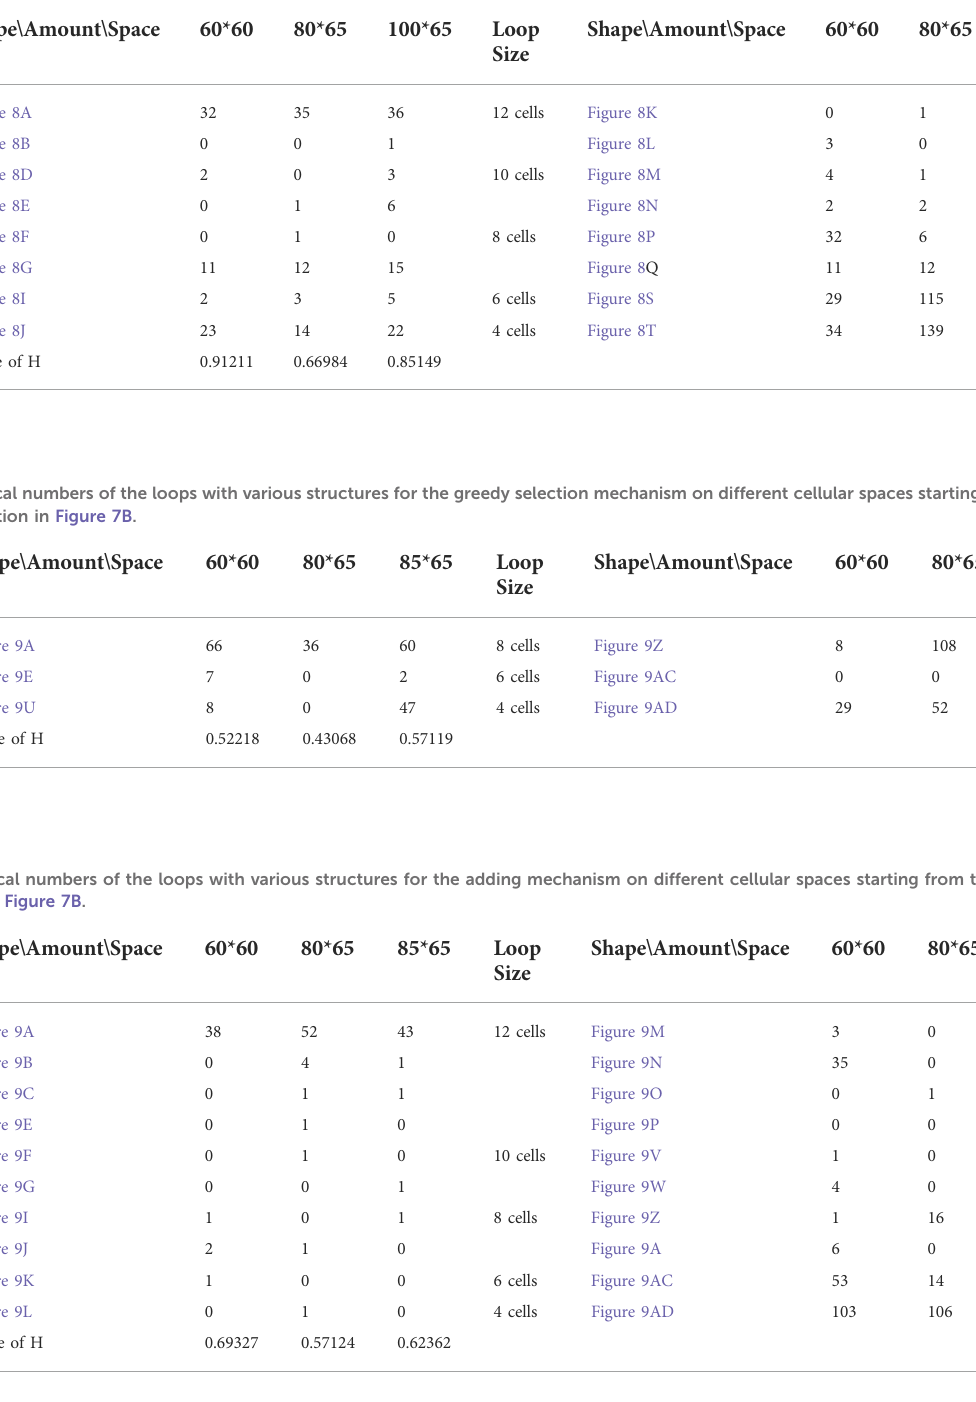
TABLE 4 Statistical numbers of the loops with various structures for the changing mechanism on different cellular spaces starting from the initial con fi guration in Figure 7A. Loop Size